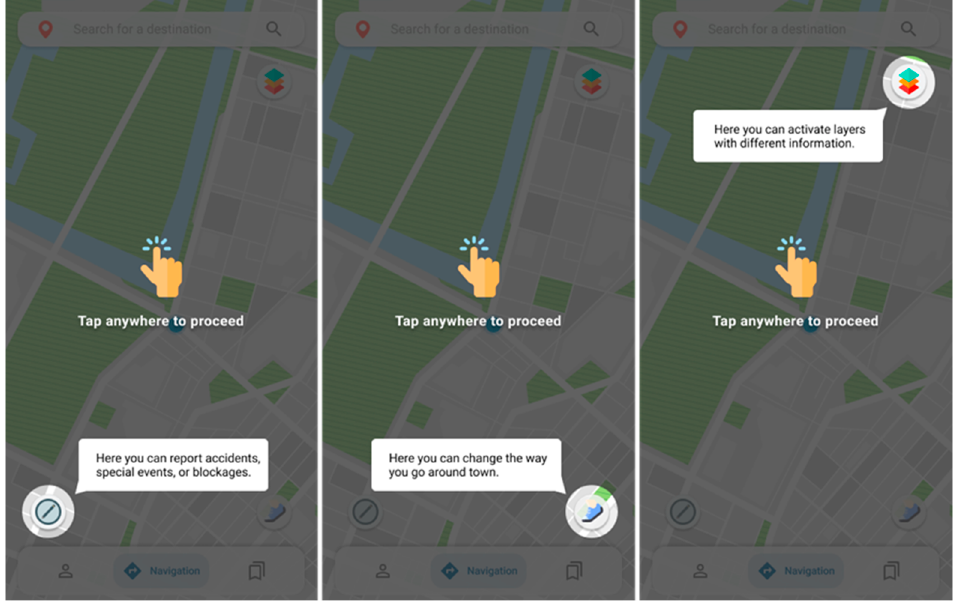
Figure 4. Screens for the explanation of basic functionalities.